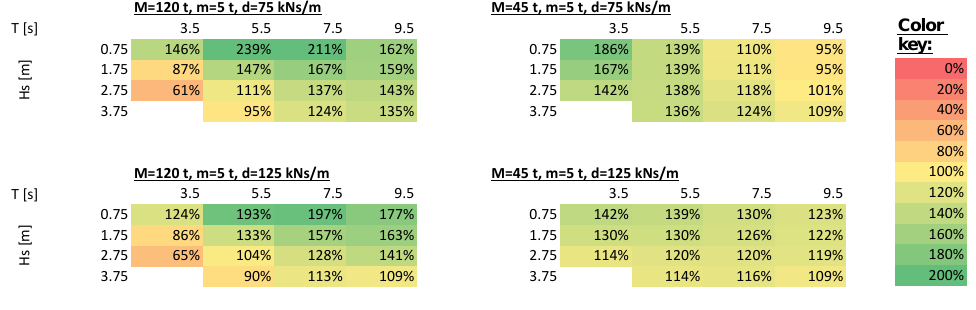
Figure 8. Matrix of power output for two direct-driven PTOs with different inertia, but the same weight, calculated by the numerical simulation and compared to a generator with M = m w , so a linear generator.